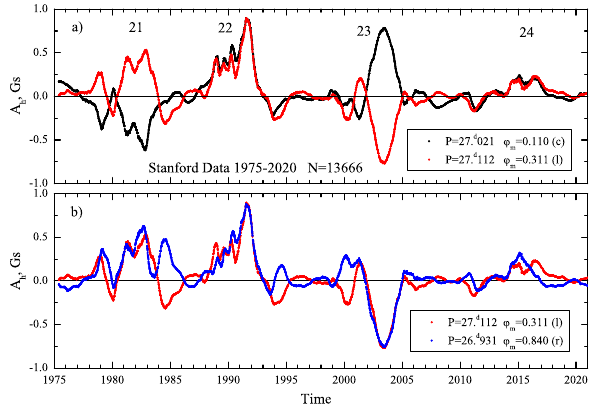
Figure 10. Changes in oscillation amplitudes with time for the cen- tral triplet of peaks from Figure 9a: a) for the central (black) and left (red) components, b) for the left (red) and right (blue) components.